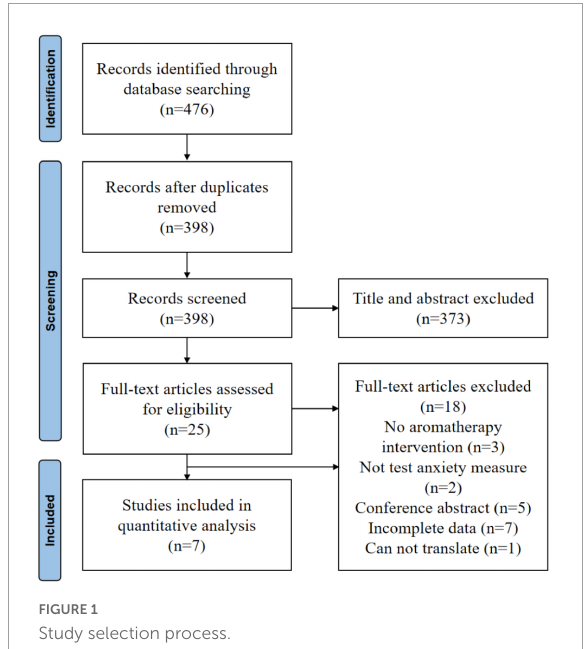
FIGURE1 Study selection